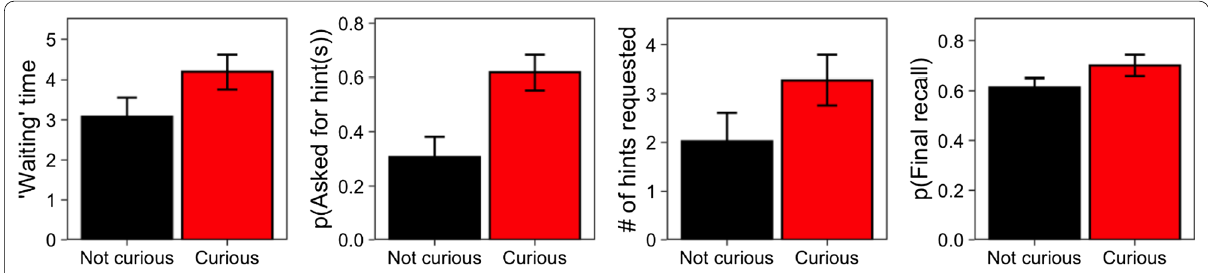
Fig. 2 Wait times, hint seeking, and final recall by curiosity, from Experiment 2. Note. Far Left: Time ‘waiting’ before requesting the answer as a function of curiosity. Left Center: Probability of asking for one or more hints as a function of curiosity. Right Center: Average number of letters (hints) viewed as a function of curiosity. Far Right: Probability of correct recall at posttest as a function of curiosity. Bars and error bars represent cross‑participant means with standard errors